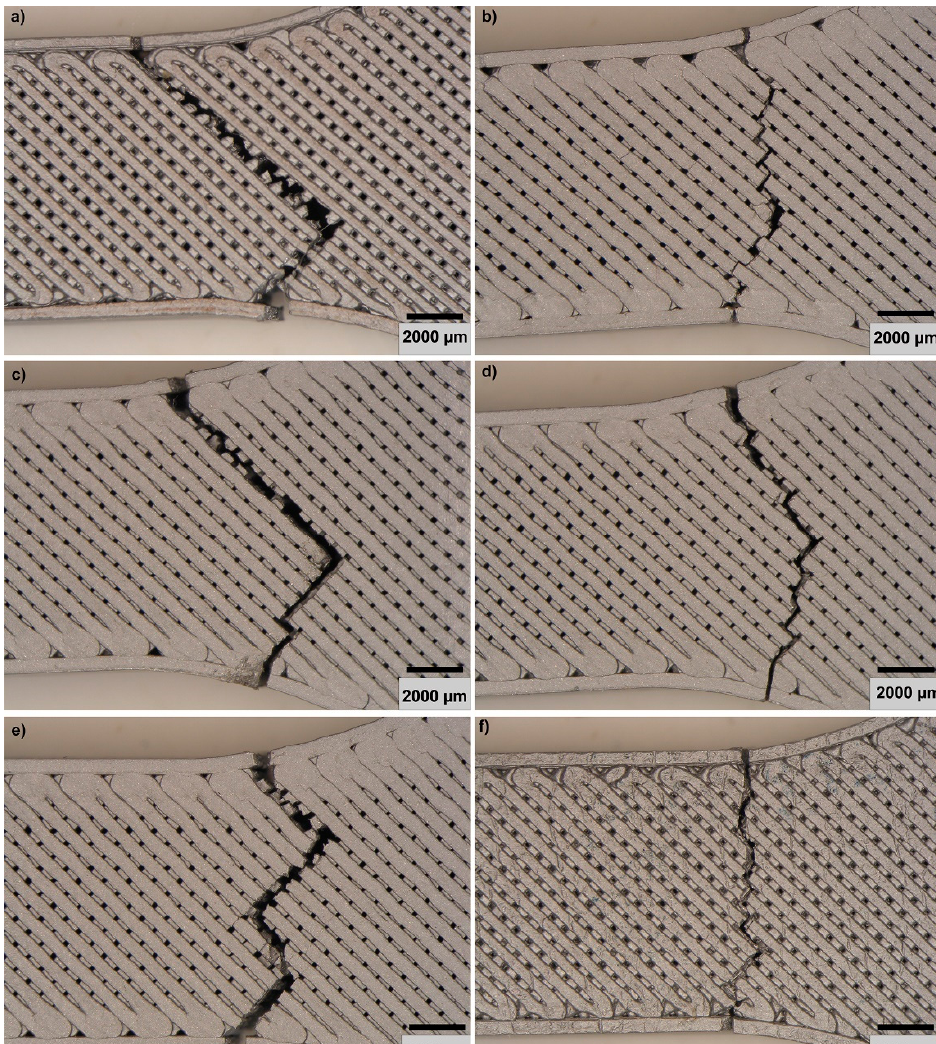
Figure 6. Macrostructural aspects at stereomicroscope of polylactic acid material with aluminum particles in longitudinal cross section, with different 3D printing parameters: ( a ) 60% interior fill percentage and 45 ° thread deposition;( b ) 60% interior fill percentage and 60 ° thread deposition;( c ) 80% interior fill percentage and 45 ° thread deposition;( d ) 80% interior fill percentage and 60 ° thread deposition; ( e ) 100% interior fill percentage and 45 ° thread deposition; ( f ) 100% interior fill percentage and 60 ° thread deposition.